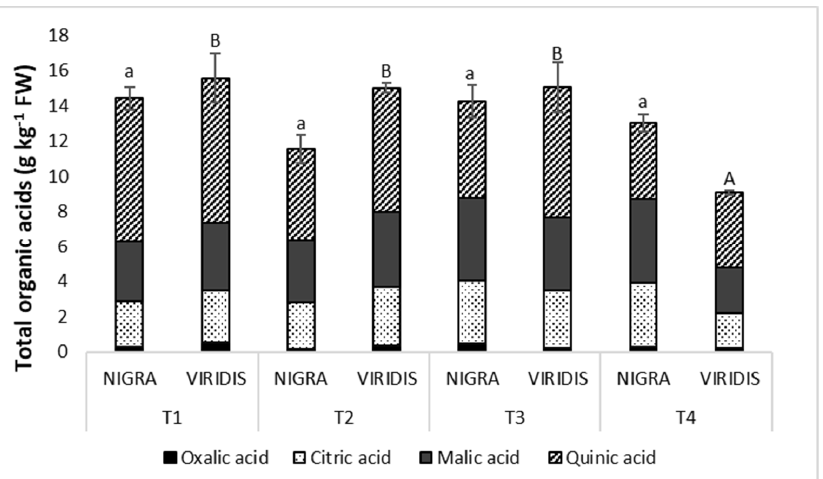
Figure 3. Content of each organic acid and total acids (g kg − 1 FW) of Sambucus nigra (NIGRA) and S. nigra var. viridis (VIRIDIS) fruits during different developmental stages (T1–T4). Different small letters (a–b) denote statistically significant differences between developmental stages for the NIGRA